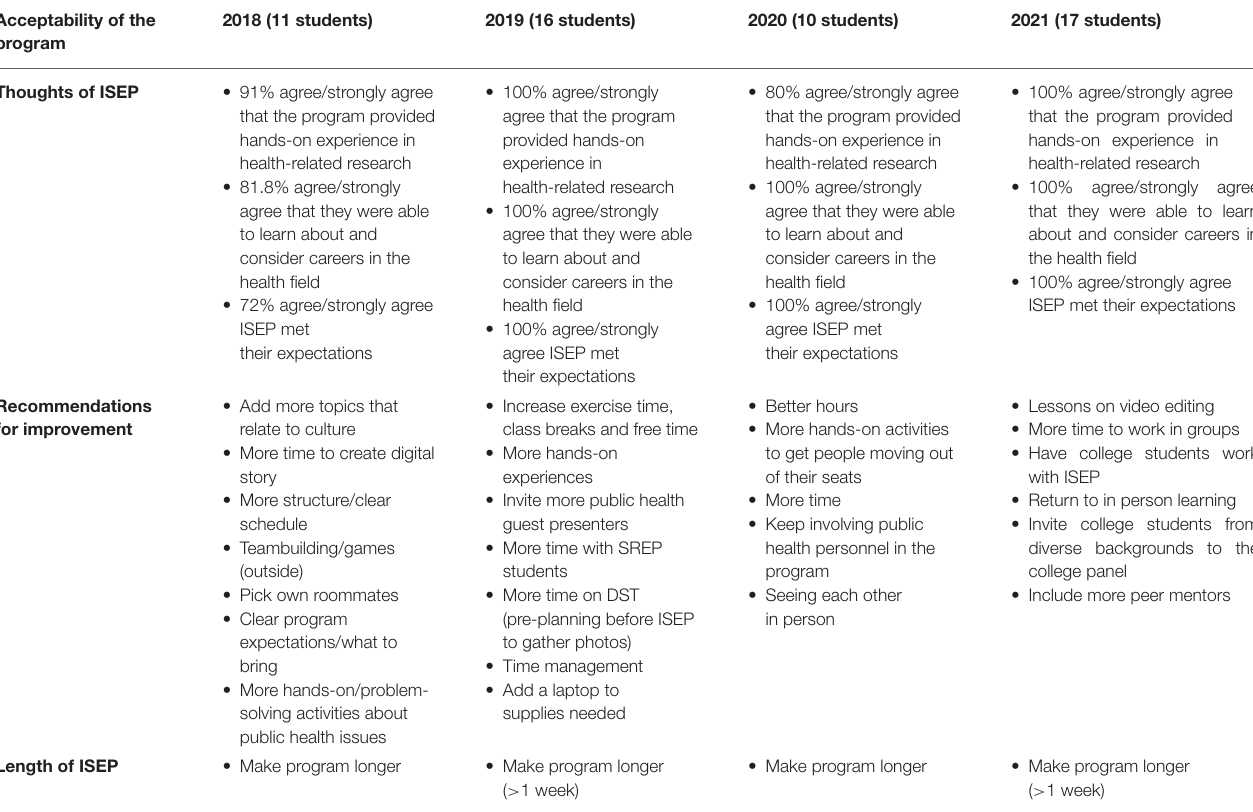
TABLE 4 | ISEP acceptability and